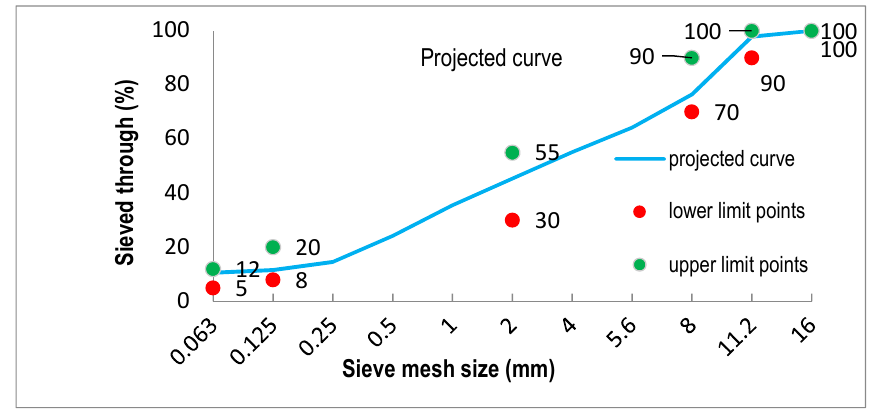
Figure 2. The graining curves for WC-1.